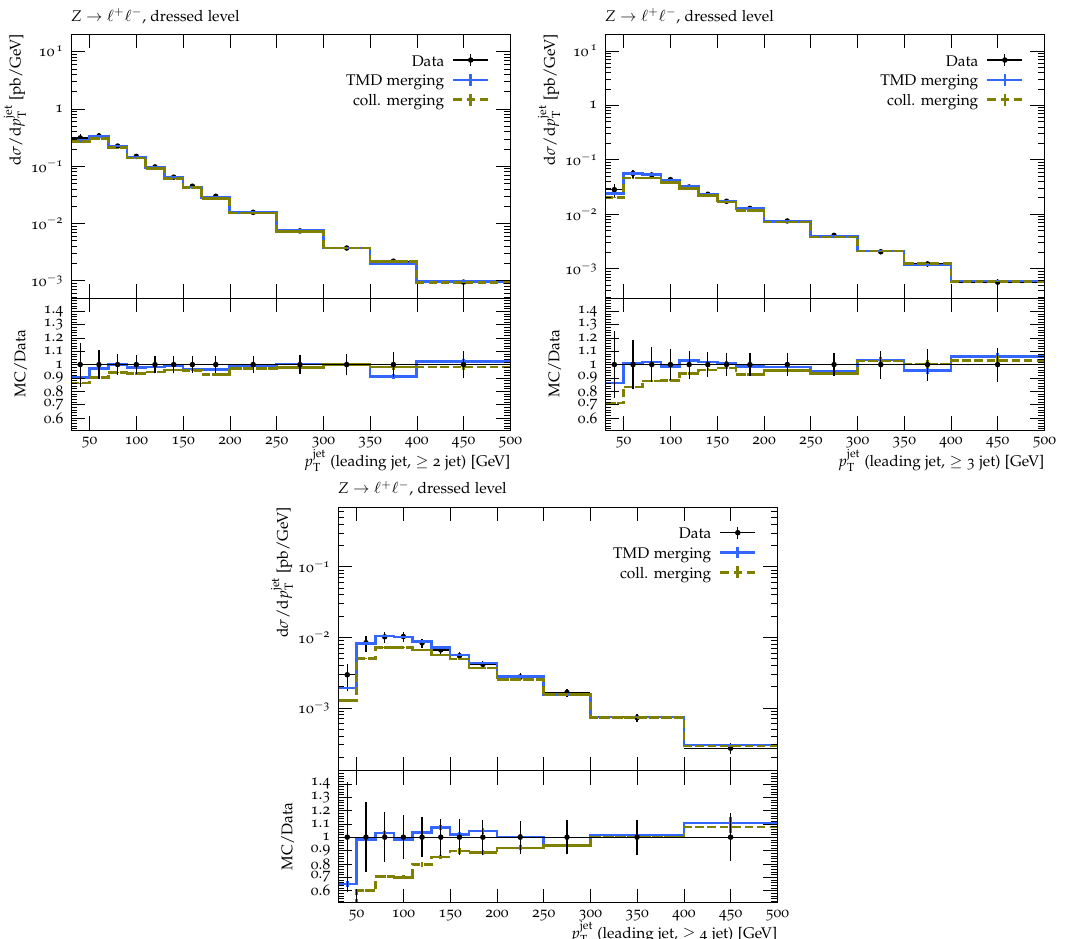
Figure 25 . Predictions obtained using Madgraph + Pythia 6 with MLM merging, and the TMD merging framework are compared for the leading jet p spectrum in inclusive Z + 2 (top left), 3 (top T right), and 4 (bottom) jets. The phase space for the calculation follows the one in